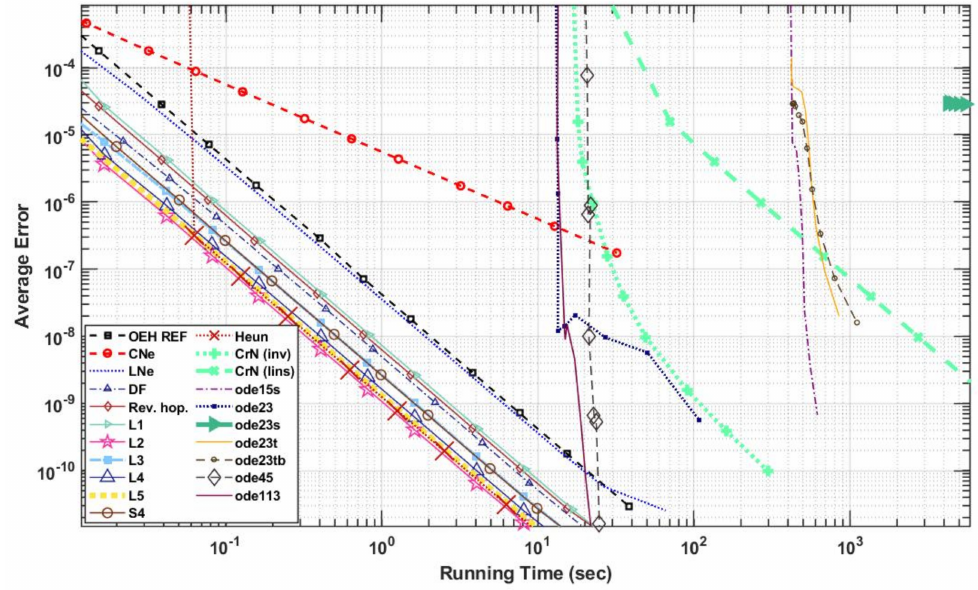
Figure 6. Errors as a function of the running time for the first (moderately stiff) system, in the case of the original OEH method (OEH REF), the new algorithms L1–L5, and several other